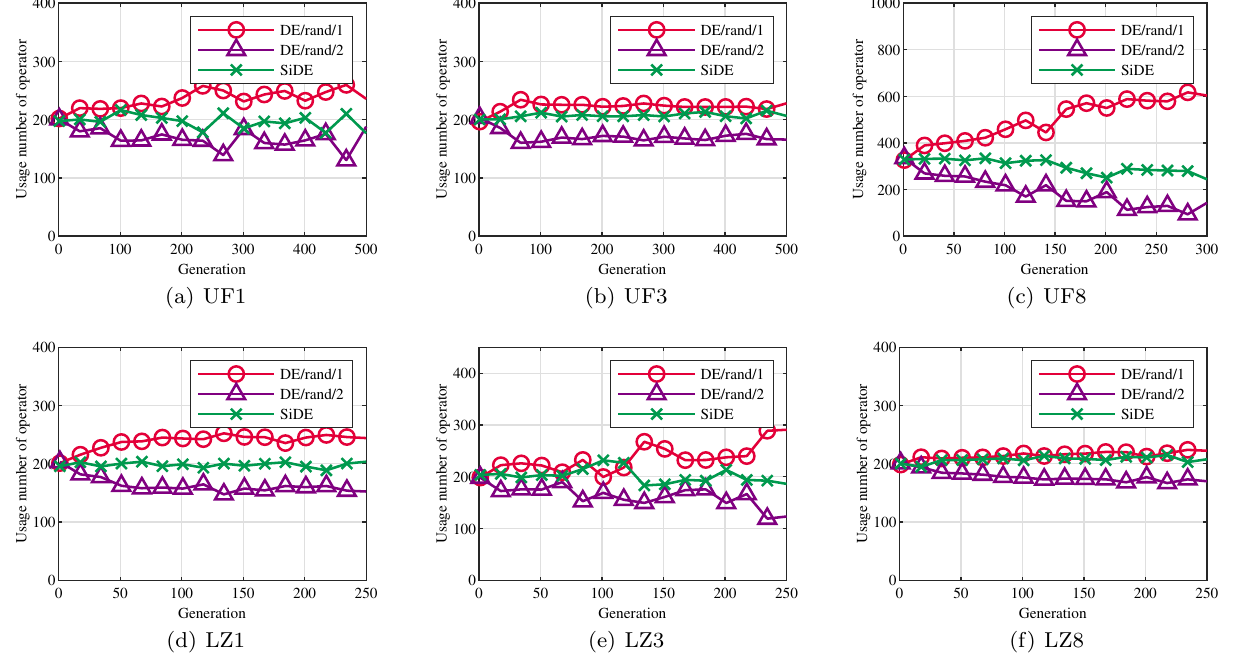
Fig. 7 The average usage times of each operator in 30 runs at different evolutionary